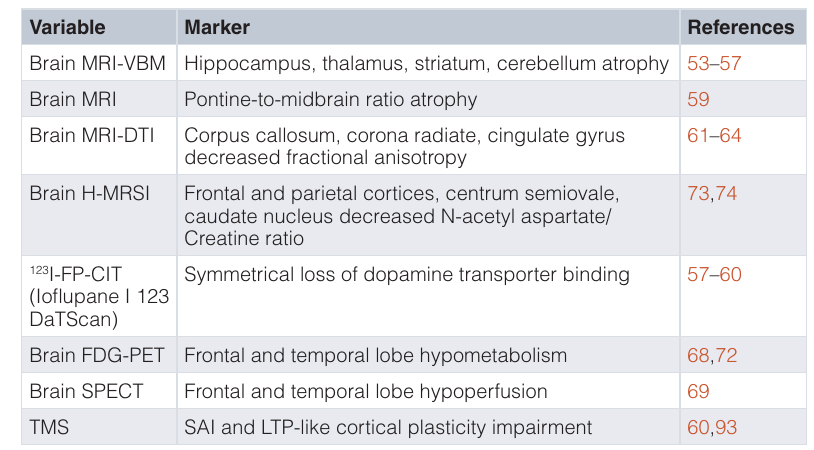
Table 1. Proposed diagnostic and prognostic markers for Niemann–Pick disease type